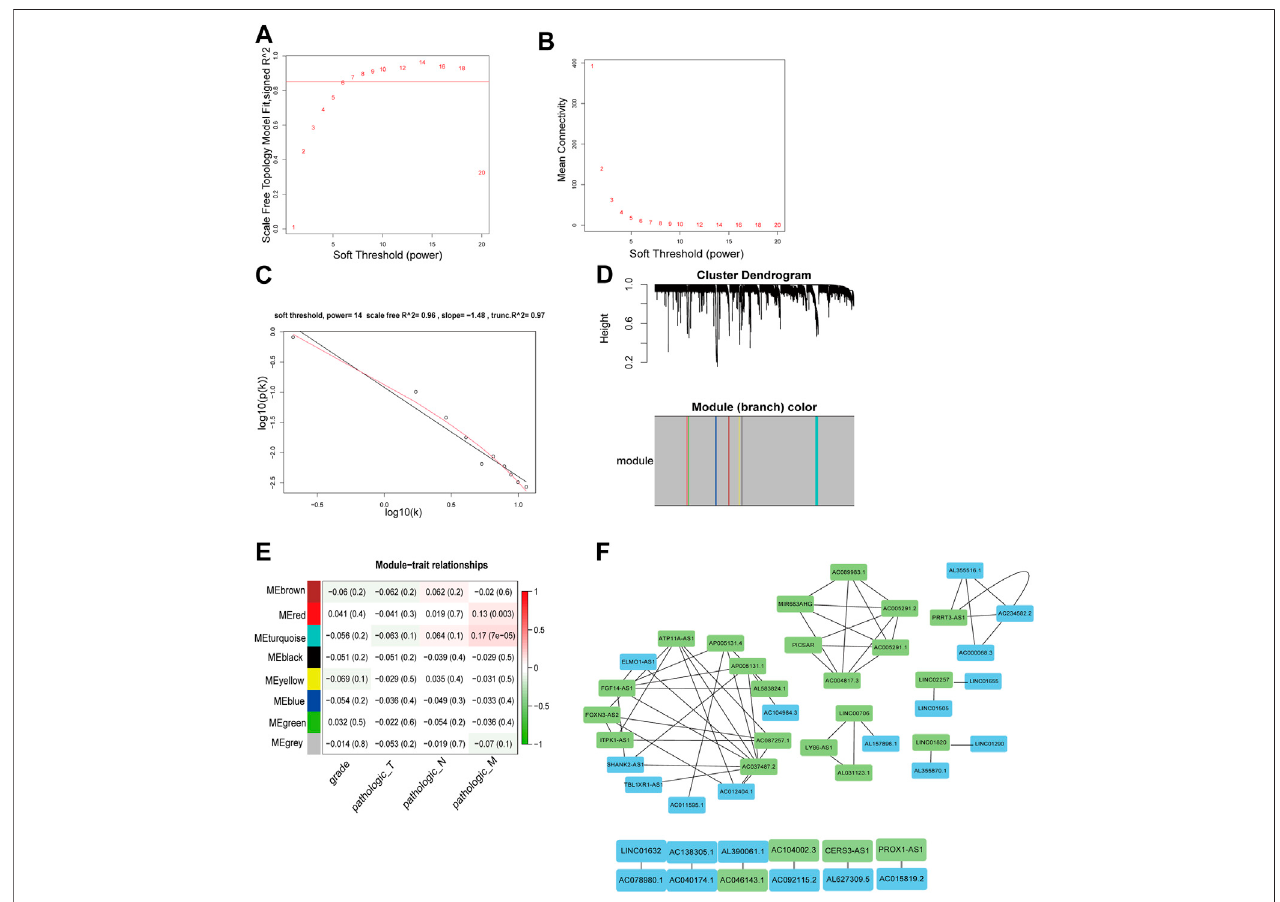
FIGURE2 | The processes ofscreening thehub m6A-lncRNAs. (A) Analysis ofthe scale-free fi tindex for various soft thresholds, and the soft threshold was set as 14. (B) Analysis of the mean connectivity for various soft thresholds. (C) Checking the scale-free topology when the soft threshold (cid:2) 14. (D) Dendrogram showing the clustered m6A-DElncRNAs. (E) Heat map illustrating the association of the MEs with clinical characteristics (including grade and TNM staging). The modules with p < 0.05 were selected. (F) Network for m6A-lncRNAs withinthe red and turquoise modules.The blue boxes mean hub-lncRNAs within the red module and the green boxes represent hub-lncRNAs within the turquoise module. And lines indicate that there is a correlation between m6A-lncRNAs.